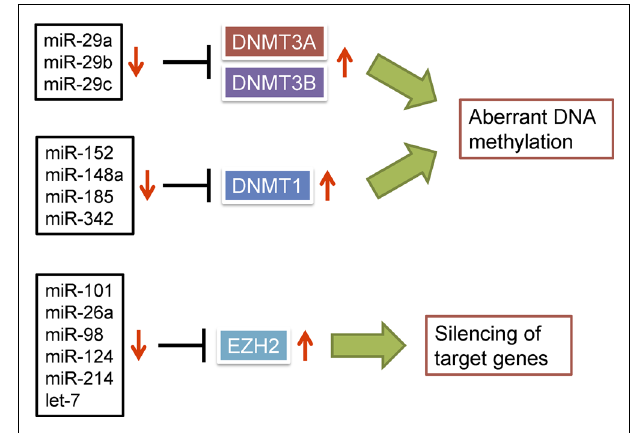
FIGURE 2 | Dysregulation of miRNAs is causally related to epigenetic alterations in cancer. miRNAs able to negatively regulate DNMTs or EZH2 are frequently downregulated in cancer, which leads to epigenetic silencing of target genes.